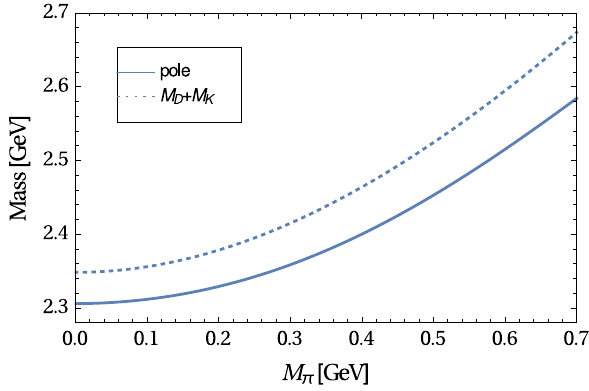
Fig. 5 The trajectory of the pole D ∗